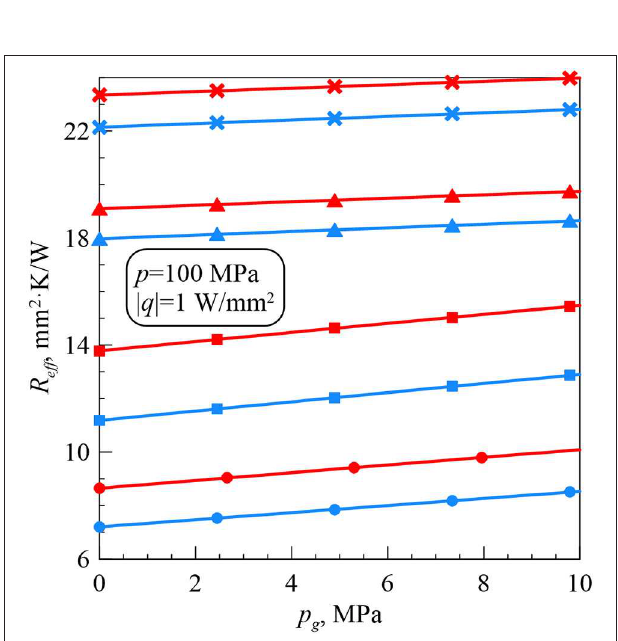
FIGURE 4 | The effective thermal contact resistance R eff vs. the gas pressure p g